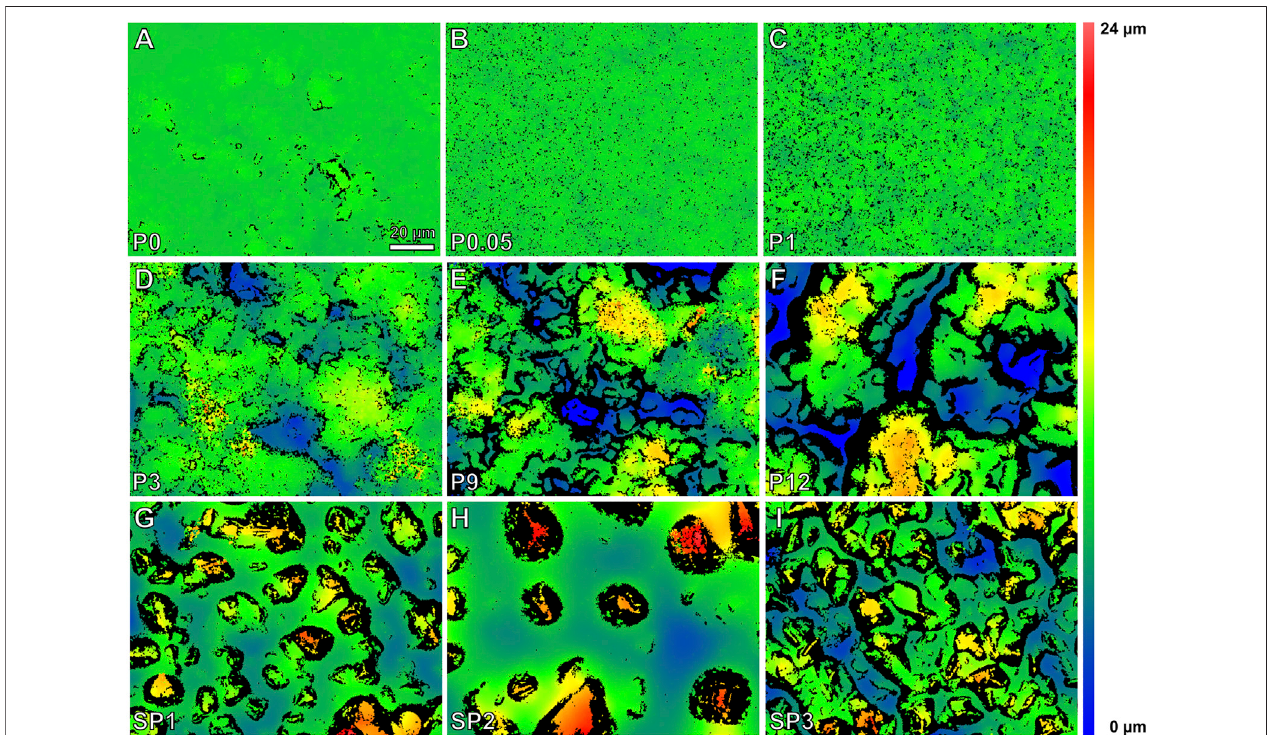
FIGURE 6 | (A – I) White light interferometric height maps of the tested epoxy resin surfaces with increasing rms roughness.